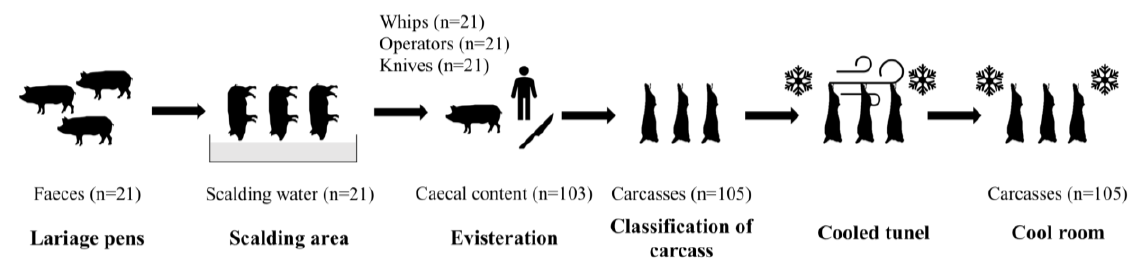
Figure 1. Samples taken during the study.